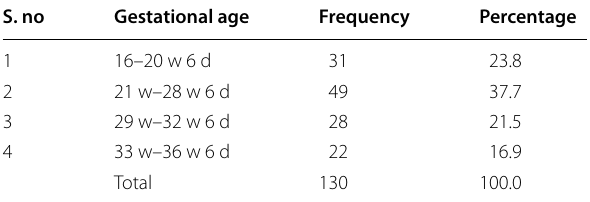
Table 1 Distribution of gestational age in weeks, in which 37.7% of the patient belong to the gestational age of 21–28 weeks